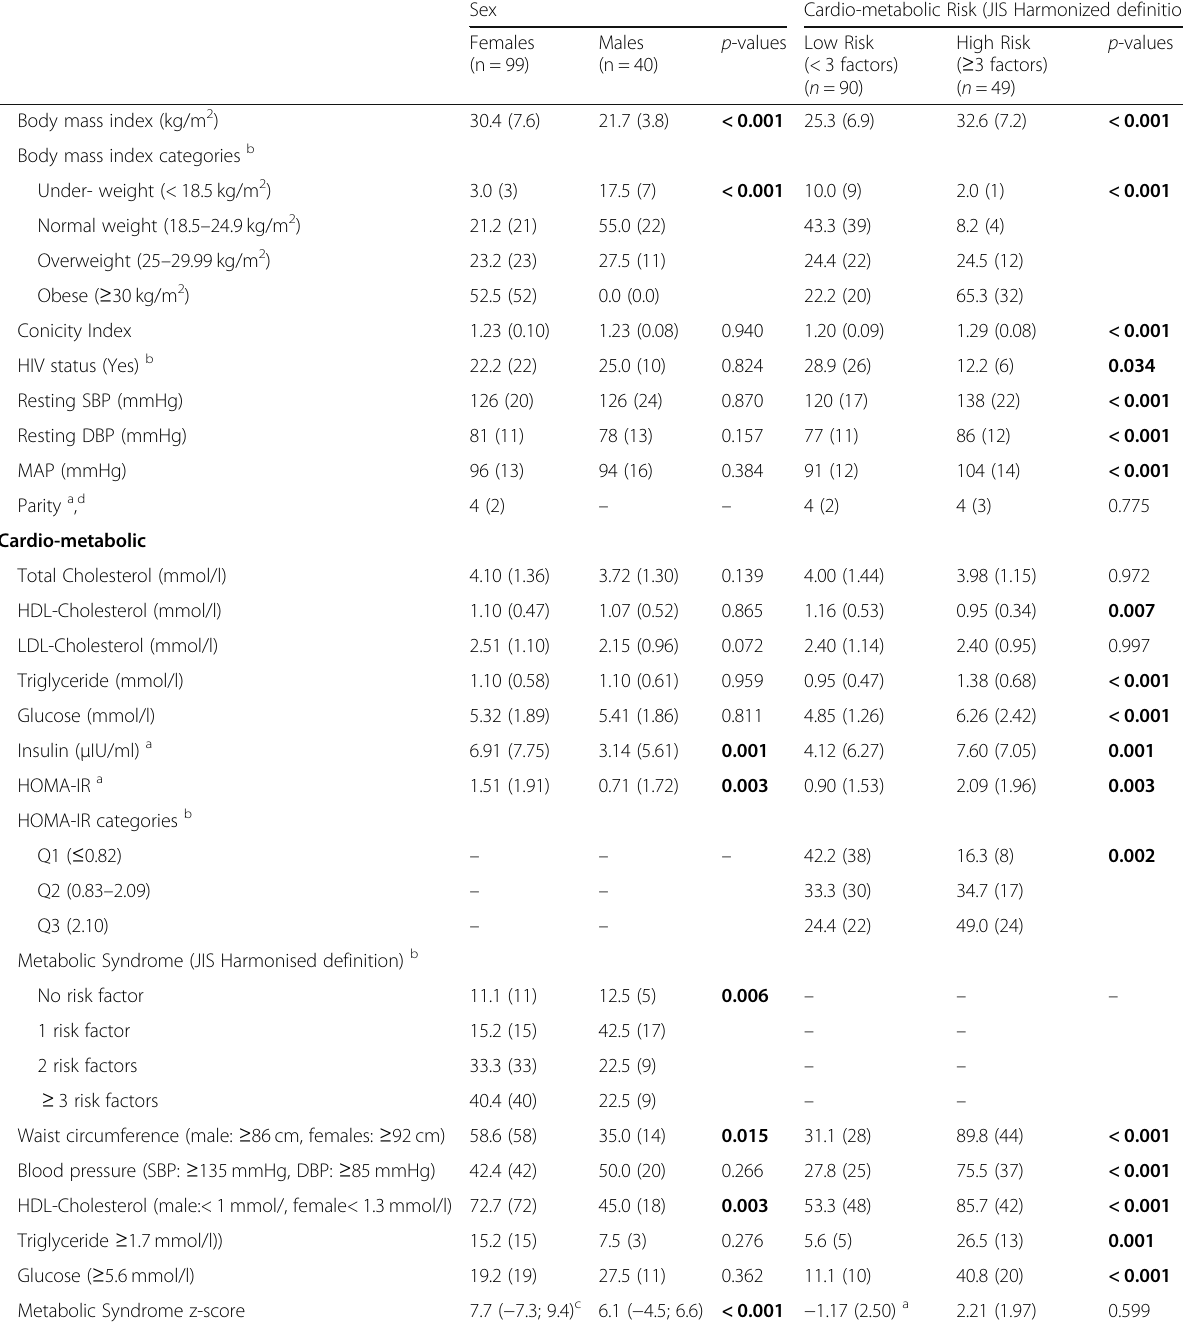
Table 1 Descriptive statistics of demographic, behavioural and biological characteristics by sex and cardio-metabolic risk